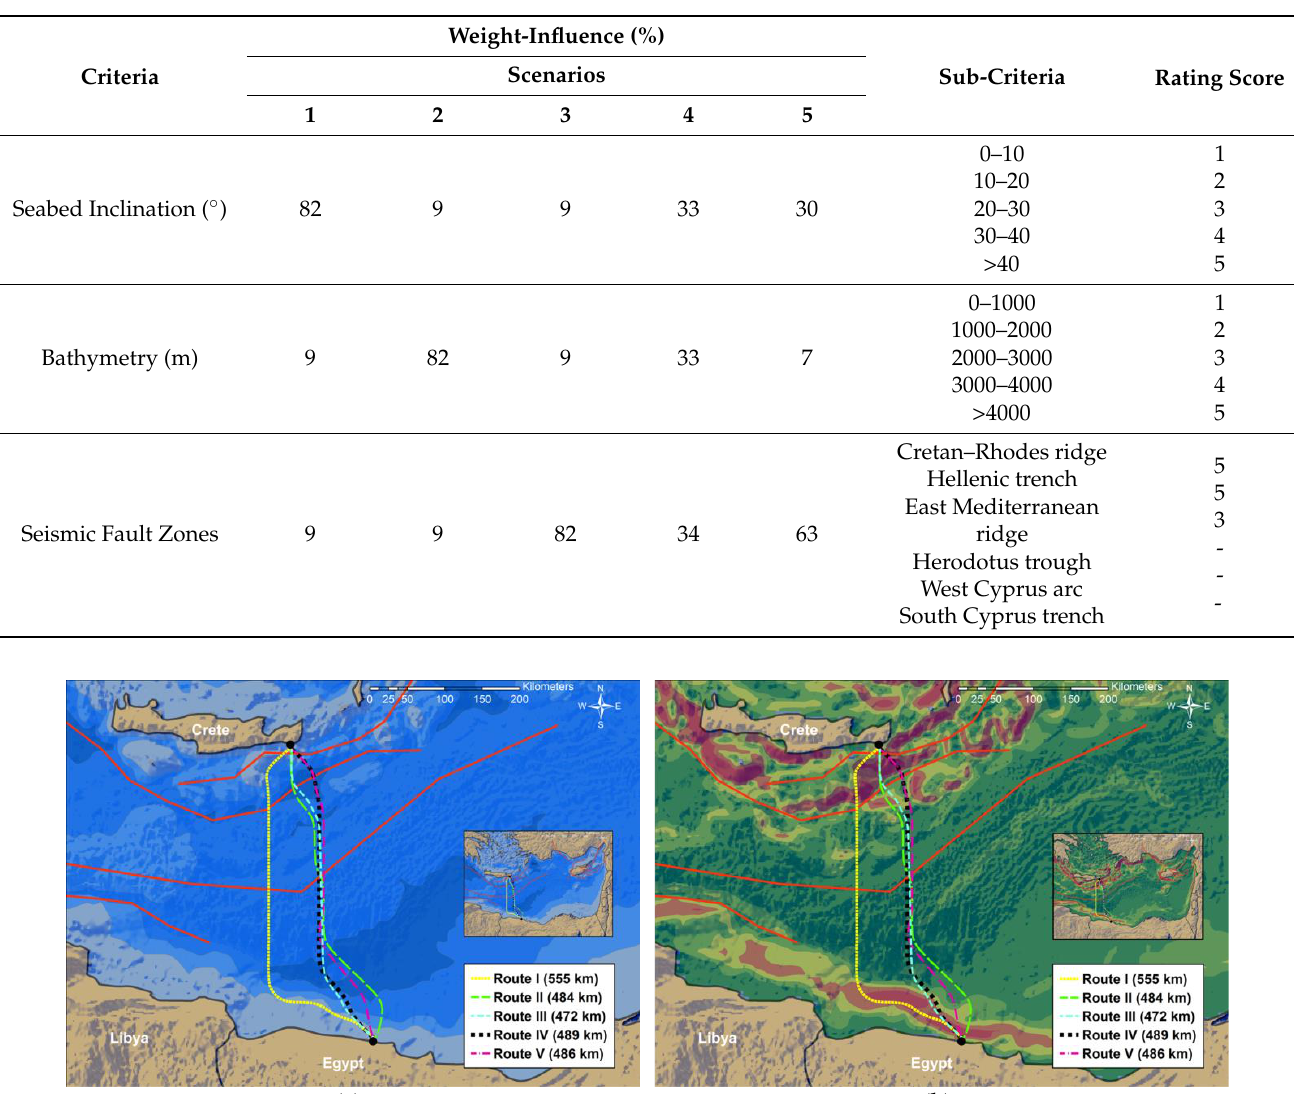
Table 4. Weight-influence and rating score of each of the adopted criteria and sub-criteria for Case Study 2.